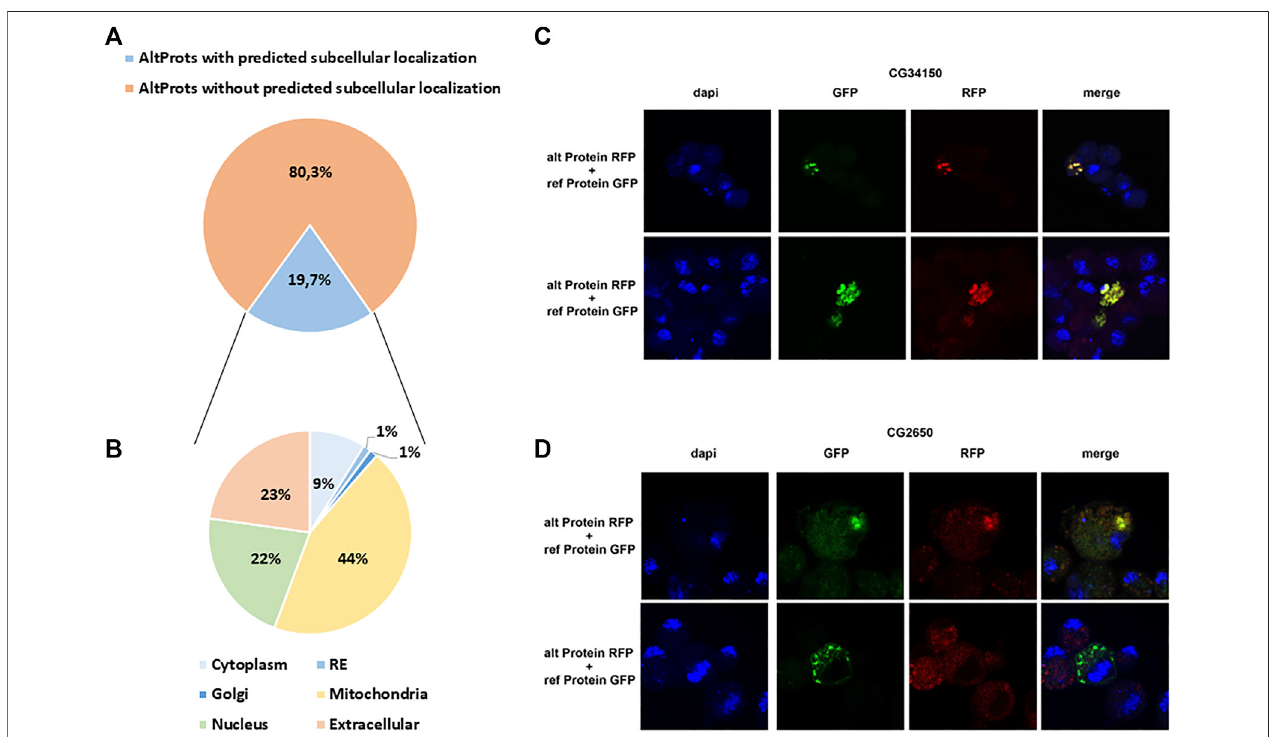
FIGURE 5 | Prediction ofalternative proteins subcellular localization. (A) . Proportion of AltProts with or without predicted subcellular localization. (B) . Proportion of AltProts predicted to be localized in different organelles. (C) . Confocal microscopy analysis of the co-expression of the AltProt (alt Protein) (with the sequence of the RefProt before the AltProt starting codon) and RefProt (ref Protein) encoded by the CG34150 gene, tagged with RFP and GFP, respectively, in S2 cells (stained with DAPI). (D) . Confocal microscopy analysis of the co-expression of the AltProt (alt Protein) (with the sequence of the RefProt before the AltProt starting codon) and RefProt (ref Protein) encoded by the CG2650 gene, tagged with RFP and GFP, respectively, in S2 cells (stained with DAPI).